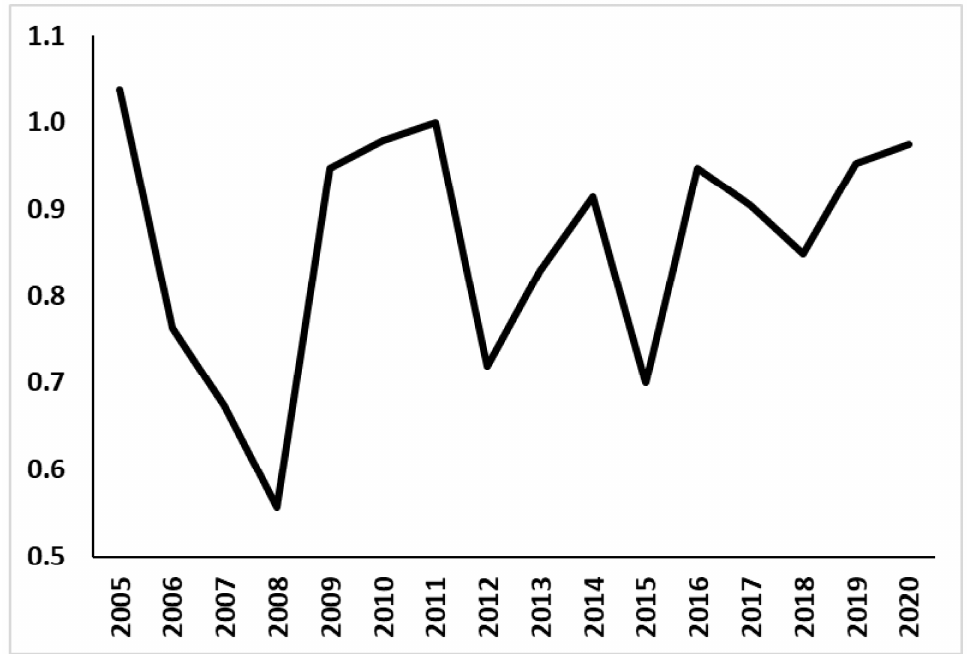
Figure 1. The overall efficiency of the Islamic banking sector over time.